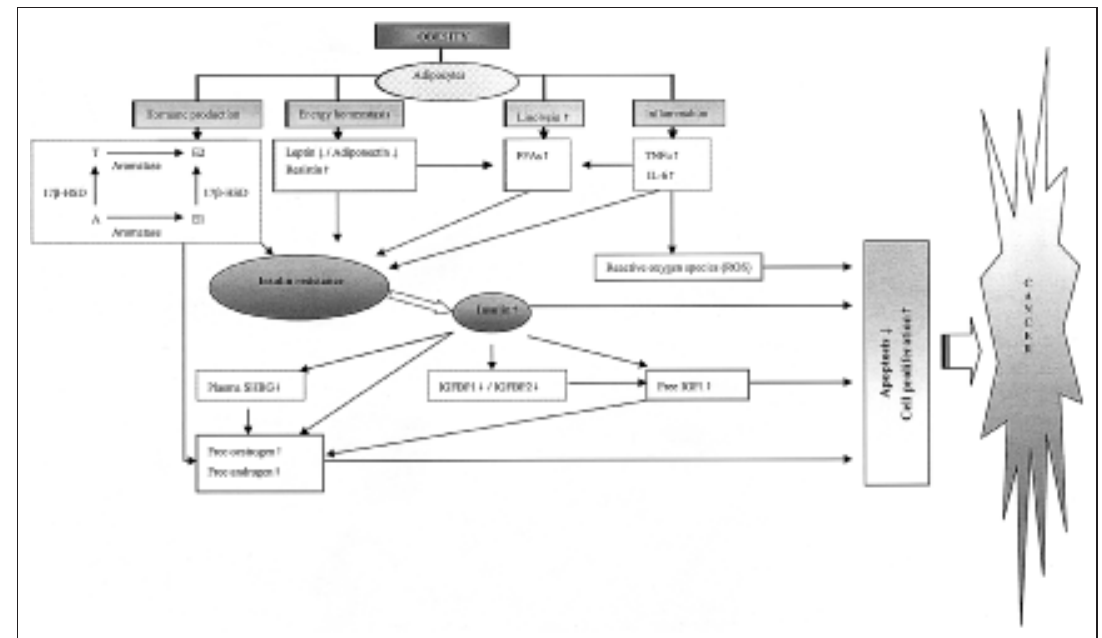
Figure 1 Mechanisms linking excess weight to in- creased cancer risk. 17 b -HSD, 17 b -hy- droxysteroid dehy- drogenase; T, Testos- teron; A, Androsten- dion; E1, oestrone; E2, oestradiol; FFAs, free fatty acids; TNF a , tumour necrosis fac- tor a ; IL-6, interleu- kin-6; SHBG, sex-hor- mon-binding globu- lin; IGFBP 1 / 2, in- sulin-like growth fac- tor binding protein 1 / 2; IGF I, insulin- like growth factor